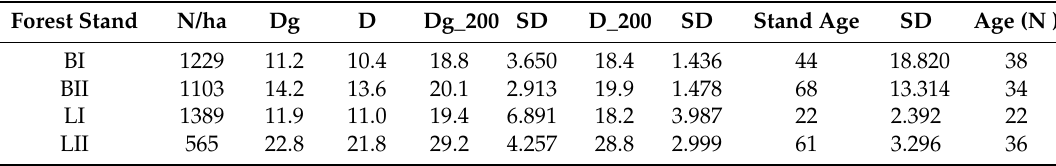
Table 2. Density measures and average dimensions and age of the light taiga study stands. Dg_200: quadratic mean diameter of the 200 strongest trees; D_200: arithmetic mean diameter of the 200 strongest trees; stand age = average age of trees based on wood cores + 5 years; SD = standard deviation; age (N): number of cores initially sampled in each stand of the main tree